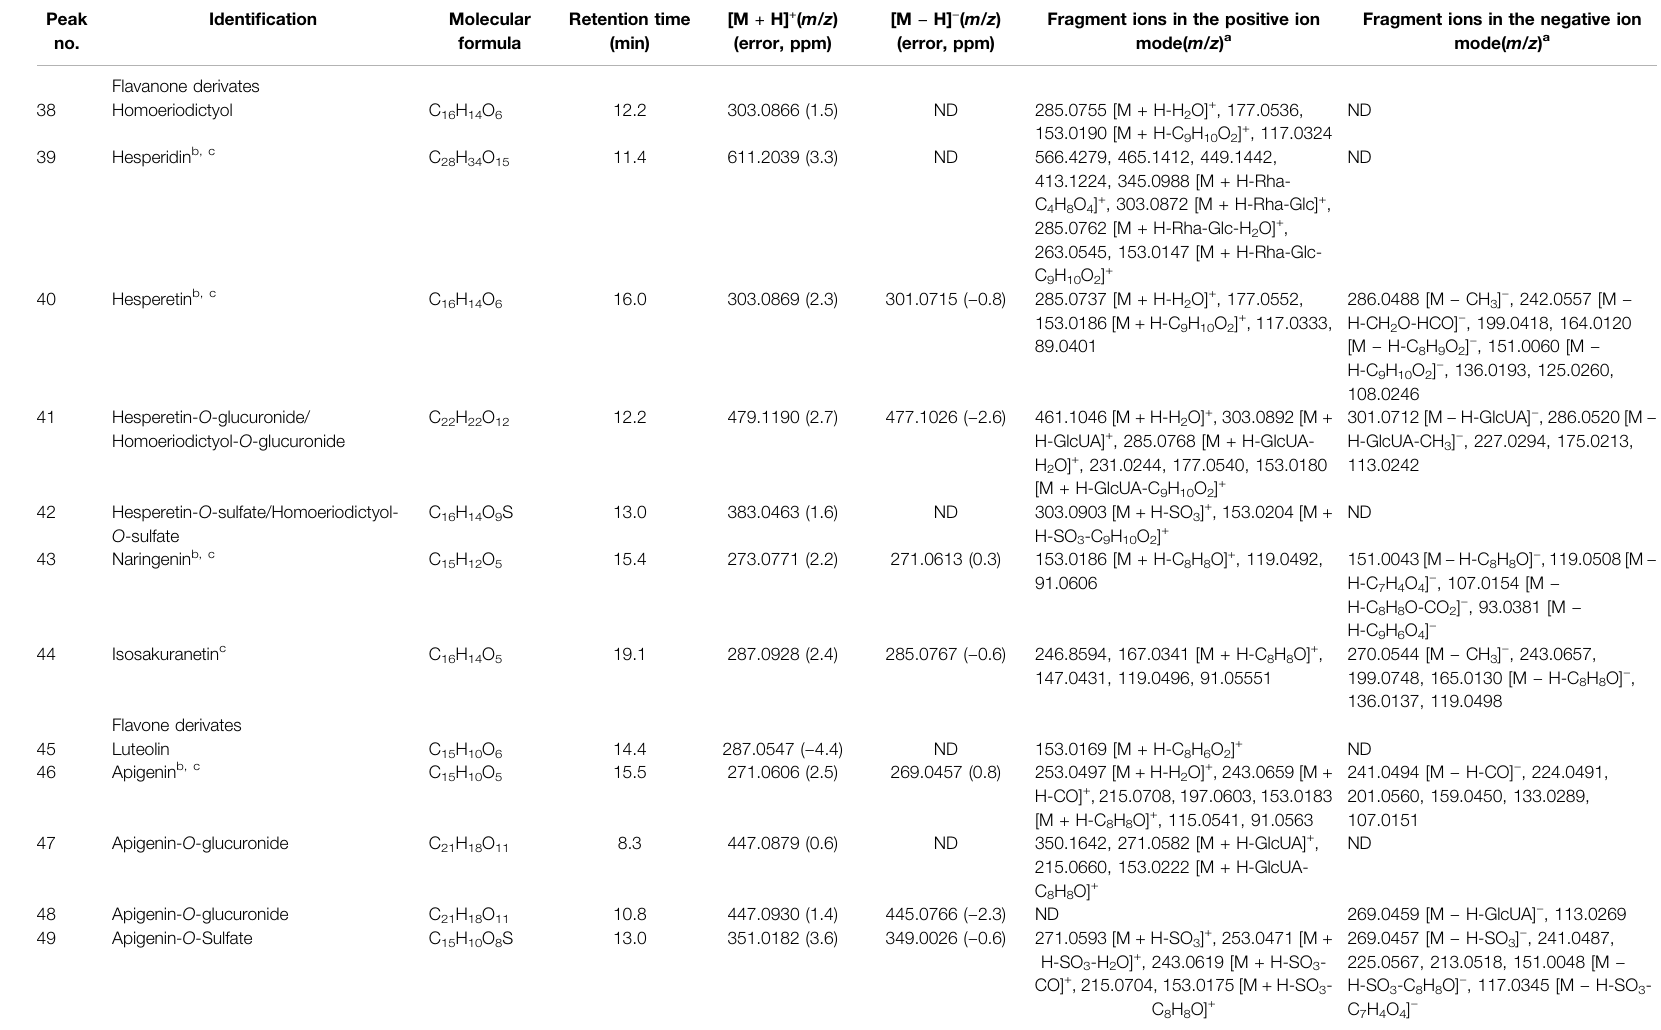
TABLE 2 | ( Continued ) Identi fi cation of metabolites in rat urine, and feces samples after the oral administration of Citri Reticulatae Pericarpium